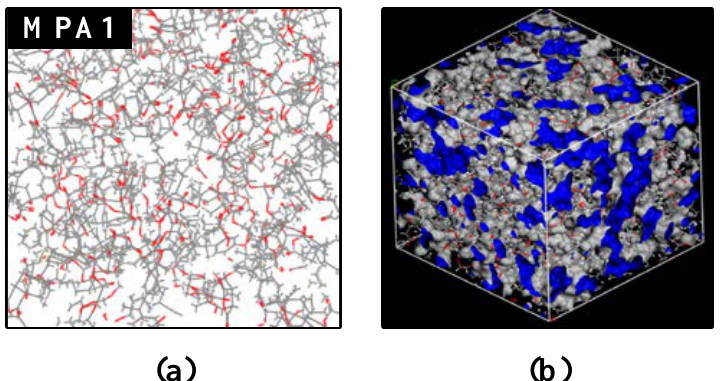
Figure 9. Molecular cross-linking mode and free volume ratio model of MPA1. ( a ) Molecular cross-linking mode, ( b ) free volume ratio model.